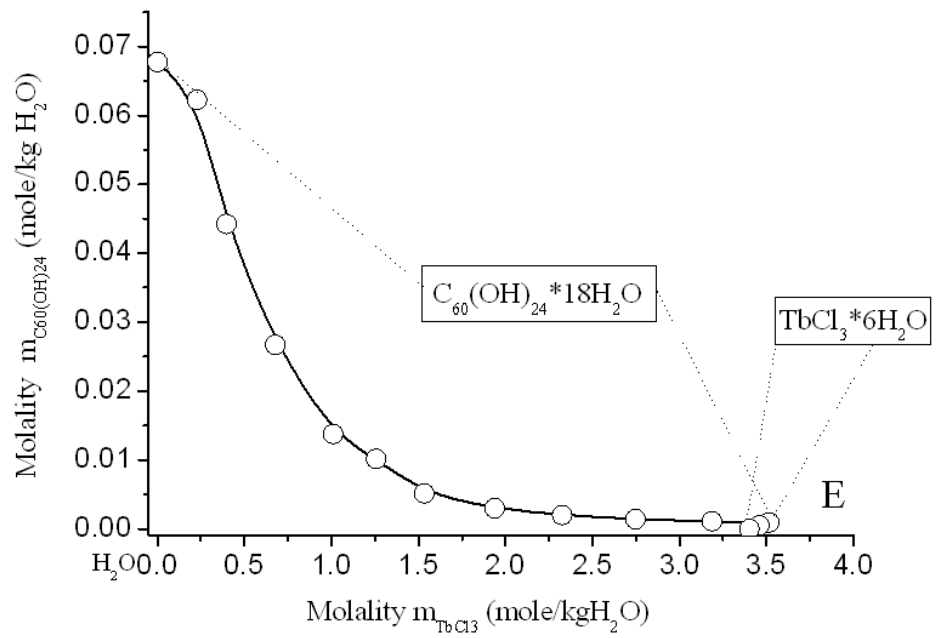
Figure 9. Solubility diagram in ternary system C 60 (OH) 24 —YCl 3 —H 2 O at 25 ◦ C.